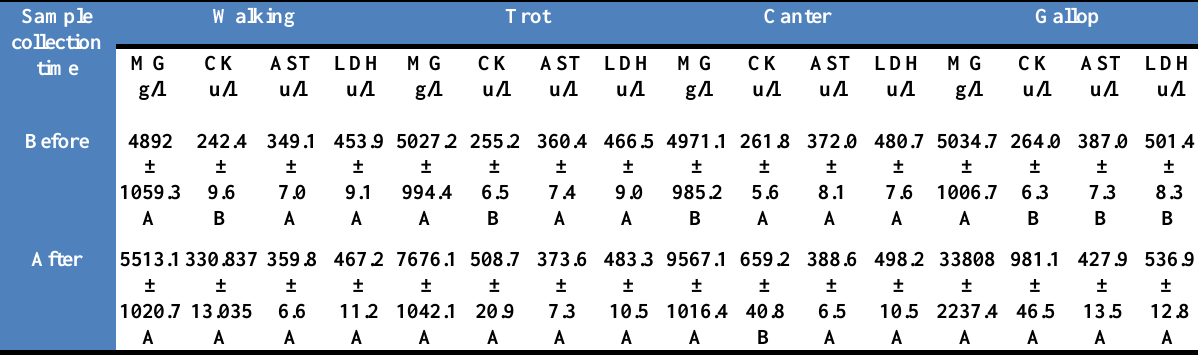
Table, 3: The mean values±SE of biochemical parameters of serum (MG, CK, AST and LDH) at different speeds.